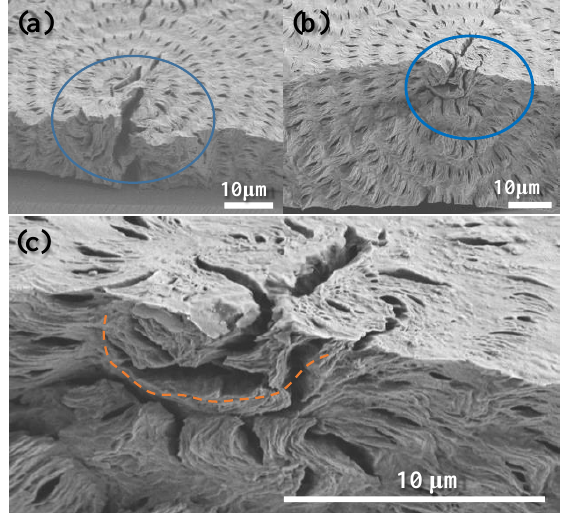
Figure 6. SEM graphs for top vs. interior of ring-banded PBA/PEO (90/10) crystallized at T c = 30 °C with film thickness: ( a ) 12 μm, ( b ) 40 μm, and ( c ) zoom-in of the graph ( b ) to the nucleus region. Blue circles indicating the nucleus zone with cracks.